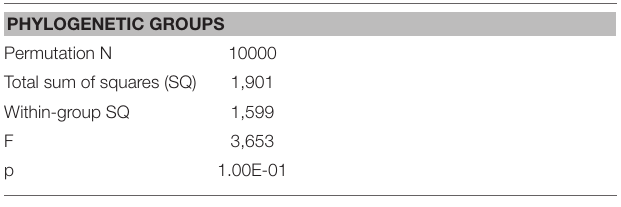
TABLE 3 | Results of one-way PERMANOVA test (10000 permutations) with 95% of variance (PC1-PC11), excluding Proganochelys and Diadectes (for phylogenetic groups